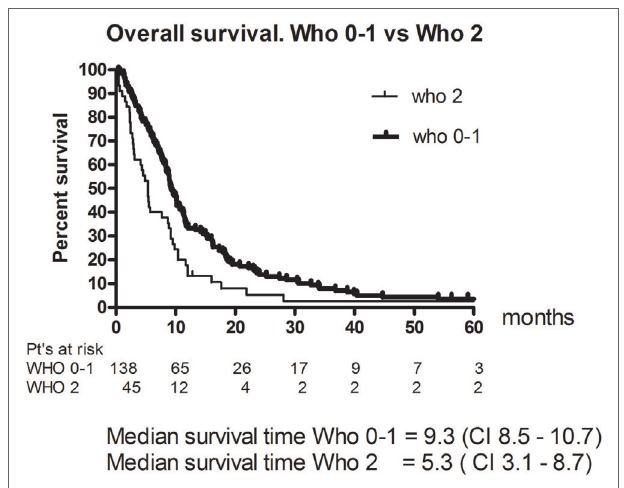
FiGUrE 2 | Overall survival for patients in WHO performance level 2 vs patients in level 0–1.